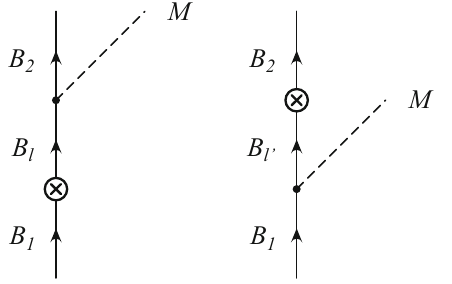
Fig. 3 s -channel contribution (left) and u -channel contribution (right)